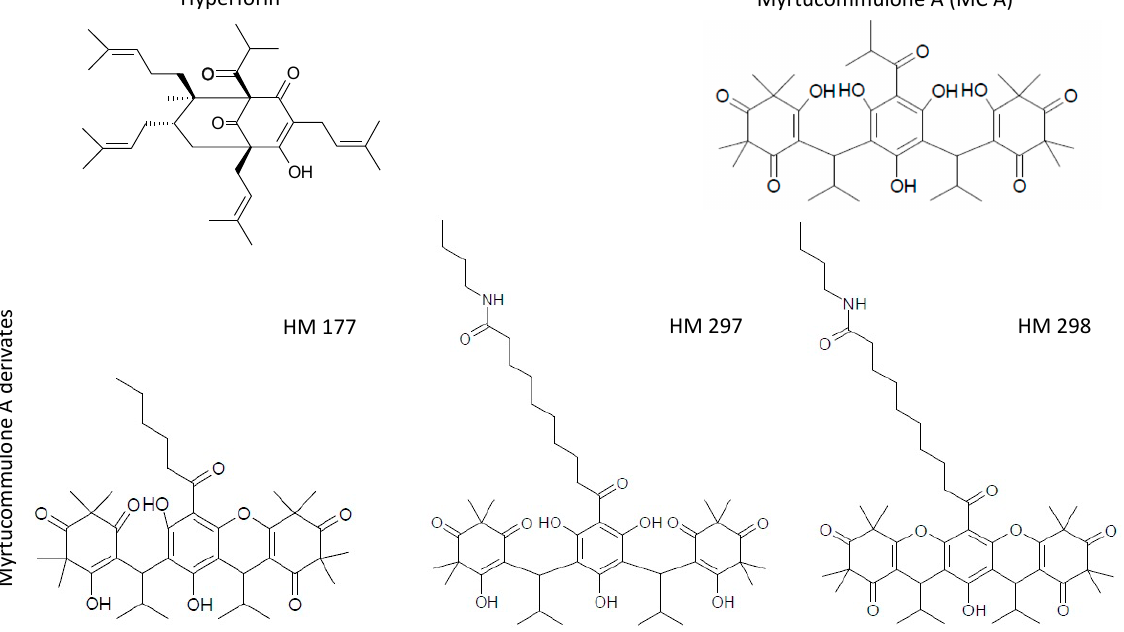
Figure 1. Chemical structures of compounds used in this study.